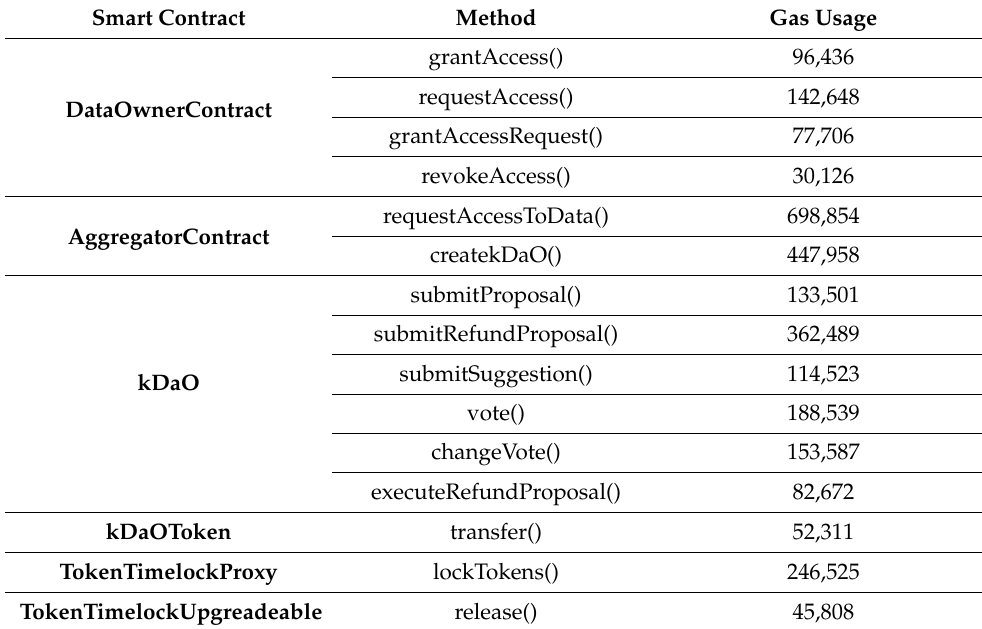
Table 4. k -DaO smart contract methods’ gas usage. Results are indicative and can change on the basis of the input